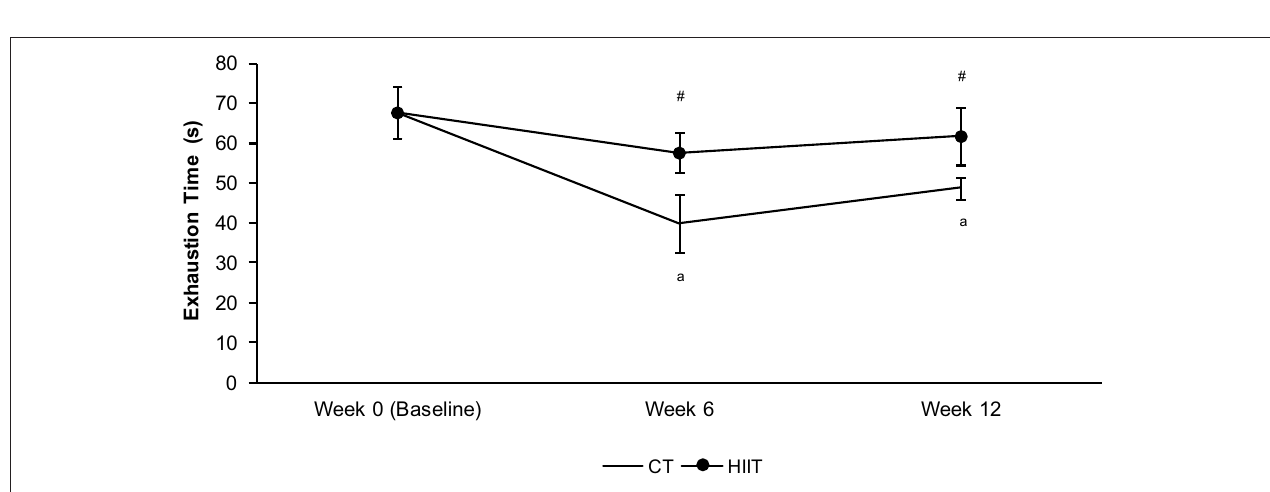
FIGURE 2 | Exhaustion time (s) at 13% of bw during the hyperlactatemia phase of the lactate minimum test. a Significantly different ( P < 0.05) in relation to baseline. # Significantly different ( P < 0.05) in relation to CT group in respective period.